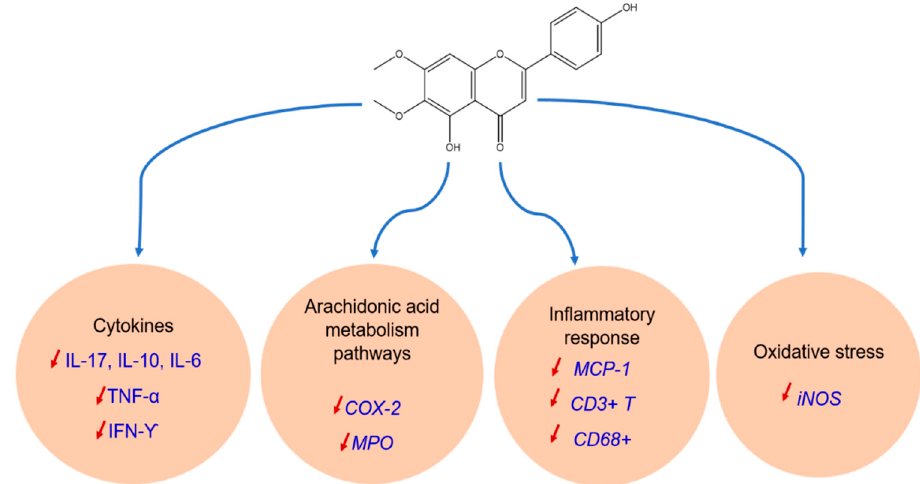
Figure 3. Anti-inflammatory mechanisms induced by cirsimaritin.